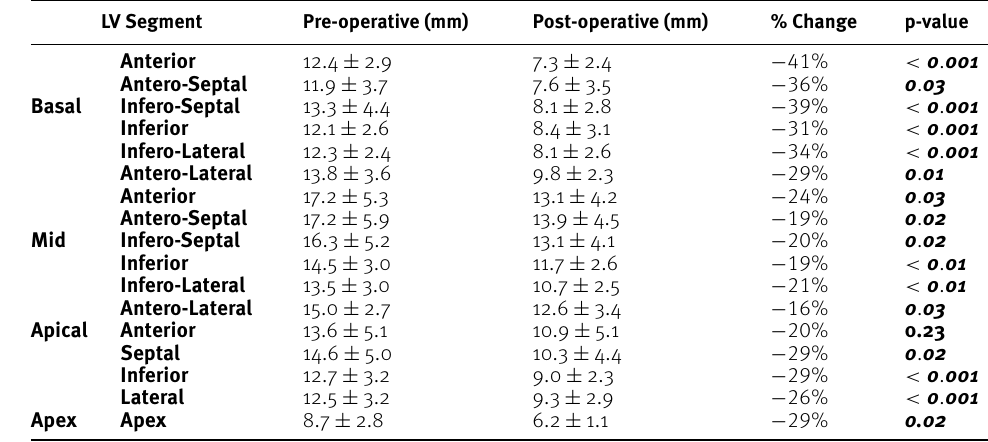
Table 2. Changes in regional LV end-diastolic thickness following tailored surgical myectomy for HCM LV Segment Pre-operative (mm) % Change p-value